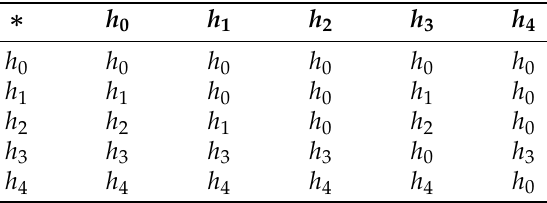
Table 2. Cayley table for the binary operation “ ∗ ”.